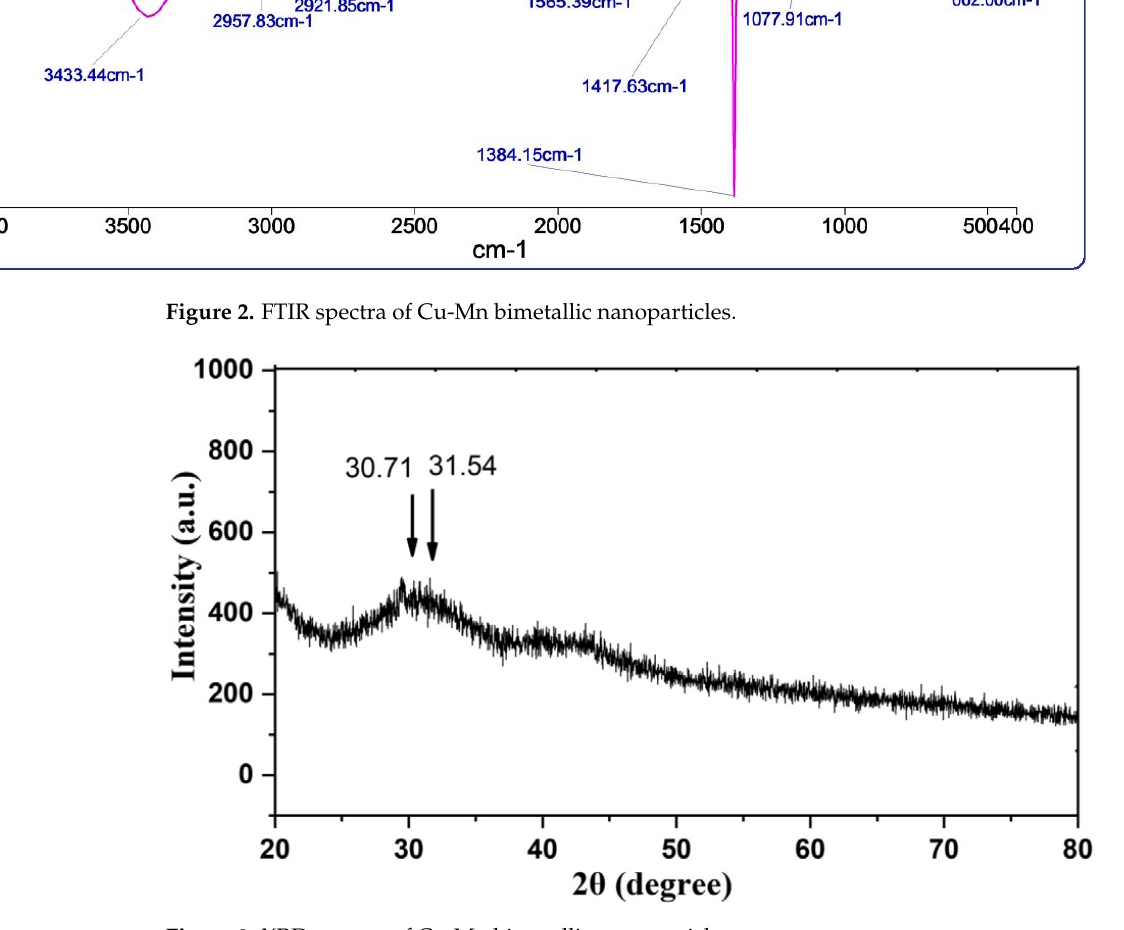
Figure 2. FTIR spectra of Cu-Mn bimetallic nanoparticles.